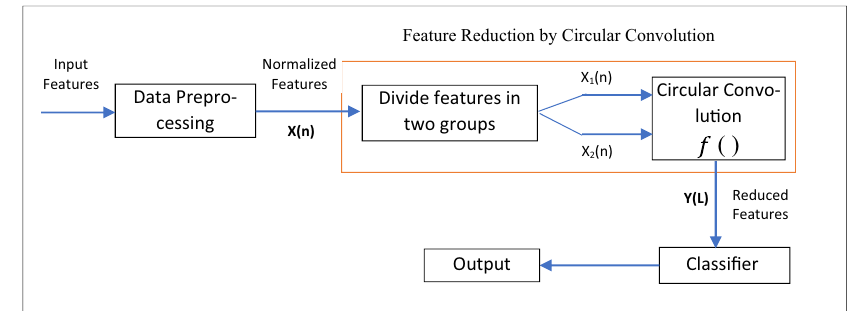
Figure 1: Proposed feature reduction system